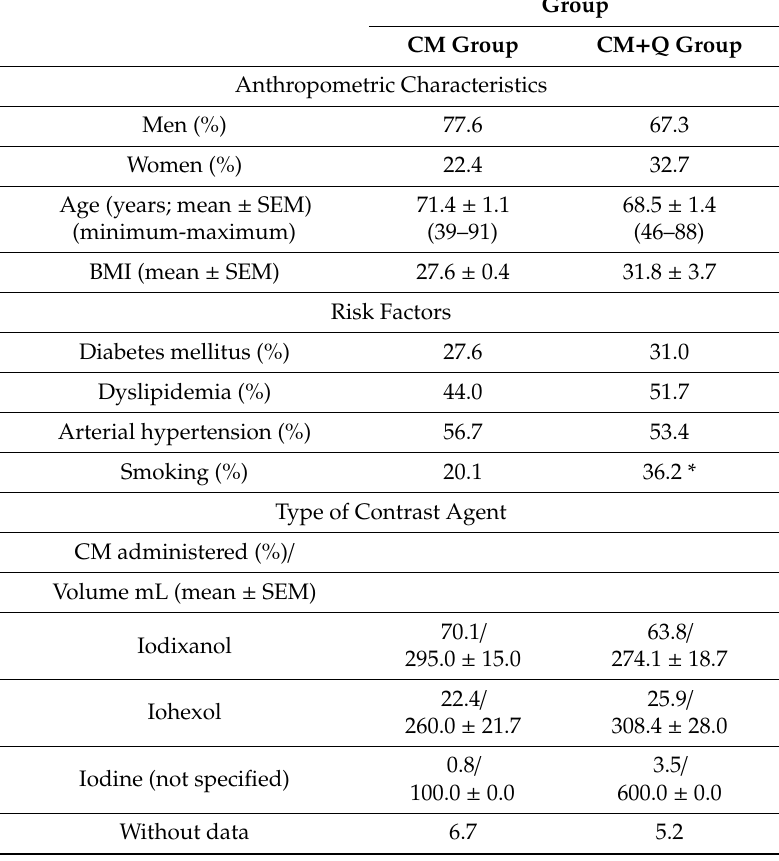
Anthropometric characteristics, risk factors associated with contrast media-induced nephropathy of patients in each study group, and information related to the contrast agent administered (for each type, percentage of patients, and volume). CM, patients who were administered iodinated contrast media; CM + Q, patients pretreated with quercetin. * p < 0.05 vs. CM group. BMI, body mass index; SEM, standard error of the